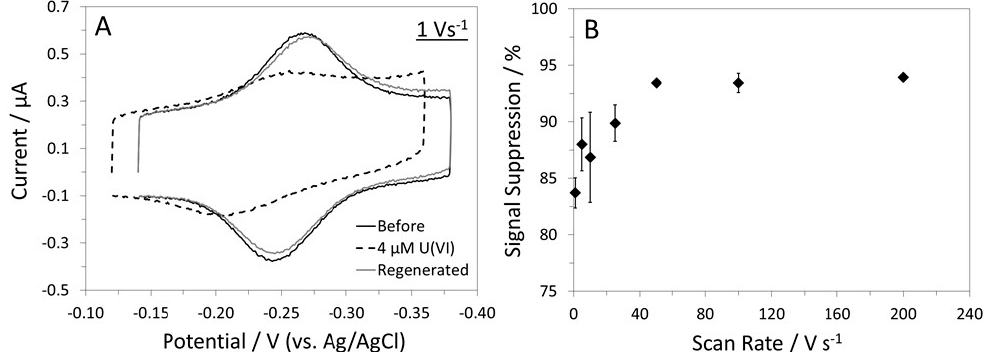
Figure 3. ( A ) CVs of the U-pT-12 sensor in a Phys2 buffer. ( B ) CV scan rate-dependent %SS plot. These results were obtained by analyzing the cathodic peak currents.